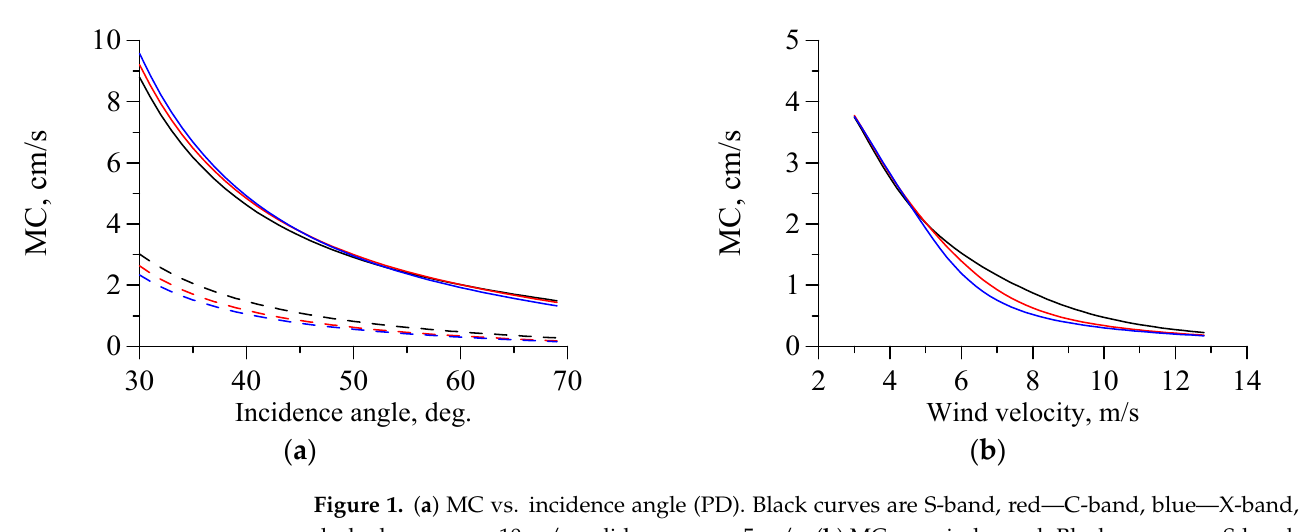
Figure 1. ( a ) M С vs. incidence angle (PD). Black curves are S-band, red—C-band, blue—X-band, dashed curves are 10 m/s, solid curves are 5 m/s. ( b ) MC vs. wind speed. Black curves are S-band, red are C-band, and blue are X-band. Incidence angle is 60 degrees.